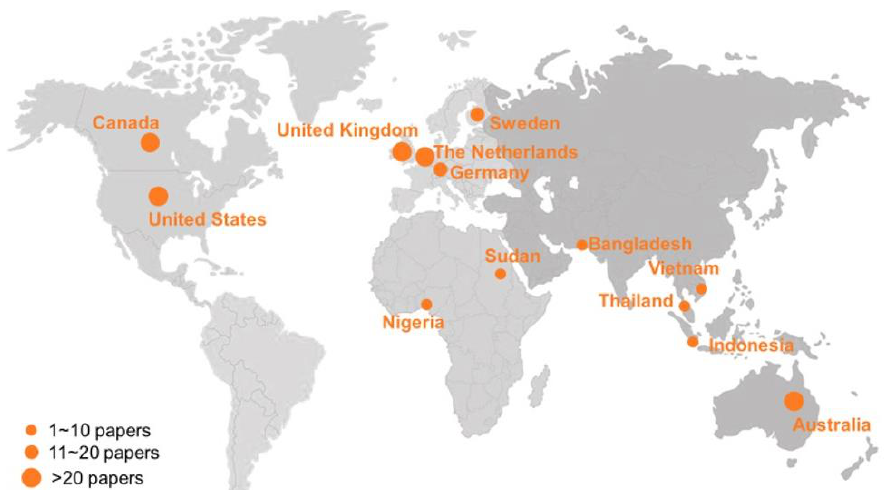
Figure 7. Geographical distribution of flood water quality assessments in the world.